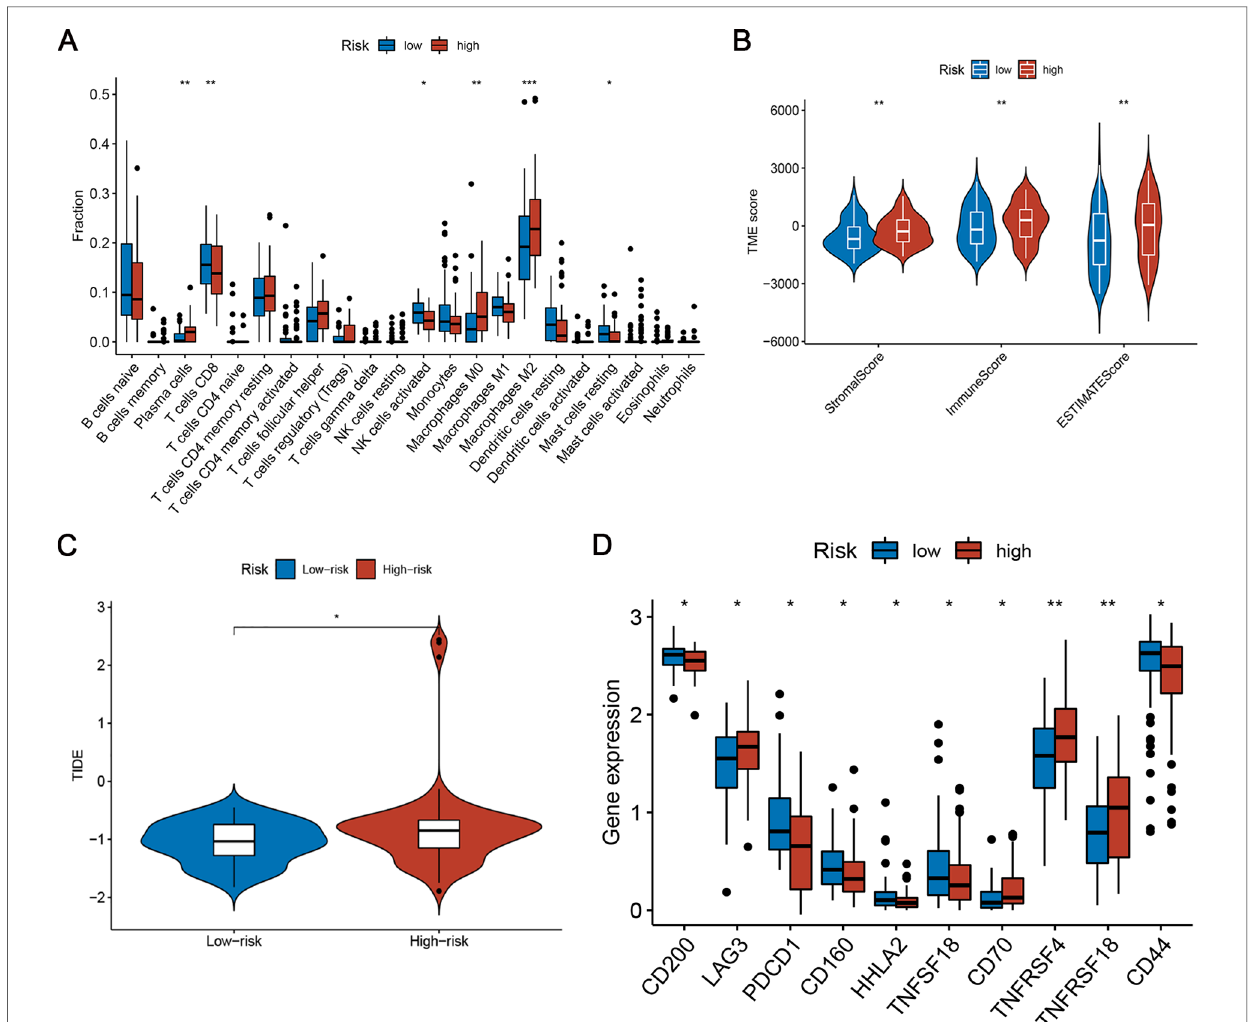
FIGURE 7 Differences in TIME characteristics and immunotherapeutic bene fi ts between different risk groups. ( A ) Comparison of immune in fi ltrating cells between low- and high-risk subgroups. ( B ) Immunity and stromal in fi ltration scores for the two risk subgroups. ( C ) Boxplot of TIDE for different risk score groups. ( D ) Analysis of immune checkpoint-related genes in the low- and high-risk